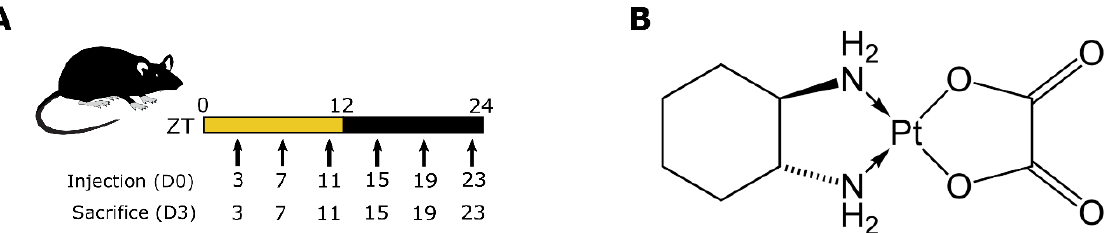
Figure 1. Experimental Methods: ( A ) Mouse investigation protocol for circadian drug injection and animal sacrifice. ( B ) Oxaliplatin molecular structure.